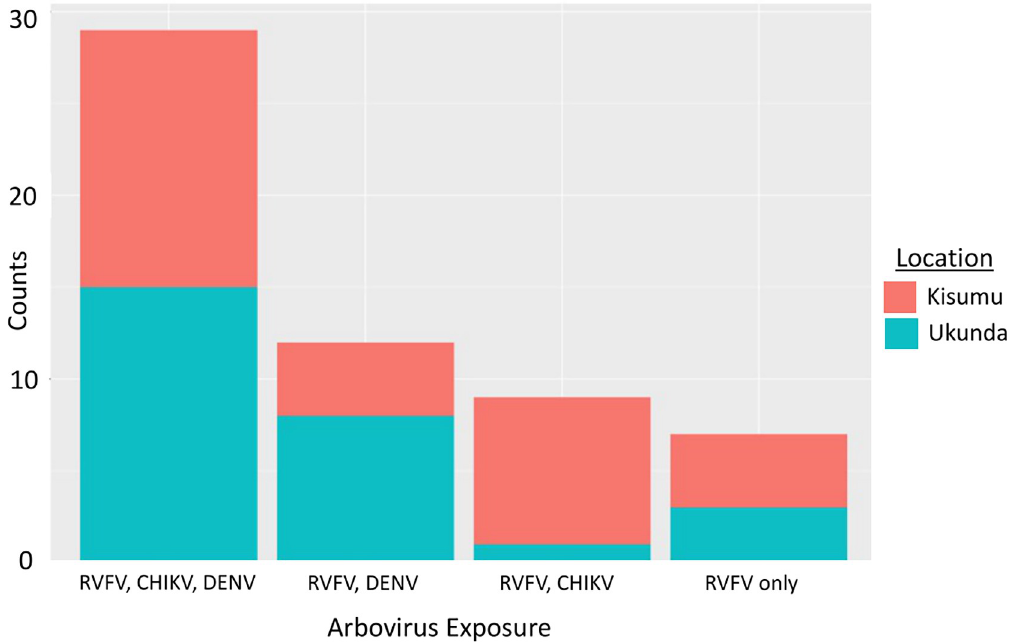
Fig 4. Counts of RVFV seropositive participant’s (n = 57) co-exposure to other arboviruses.